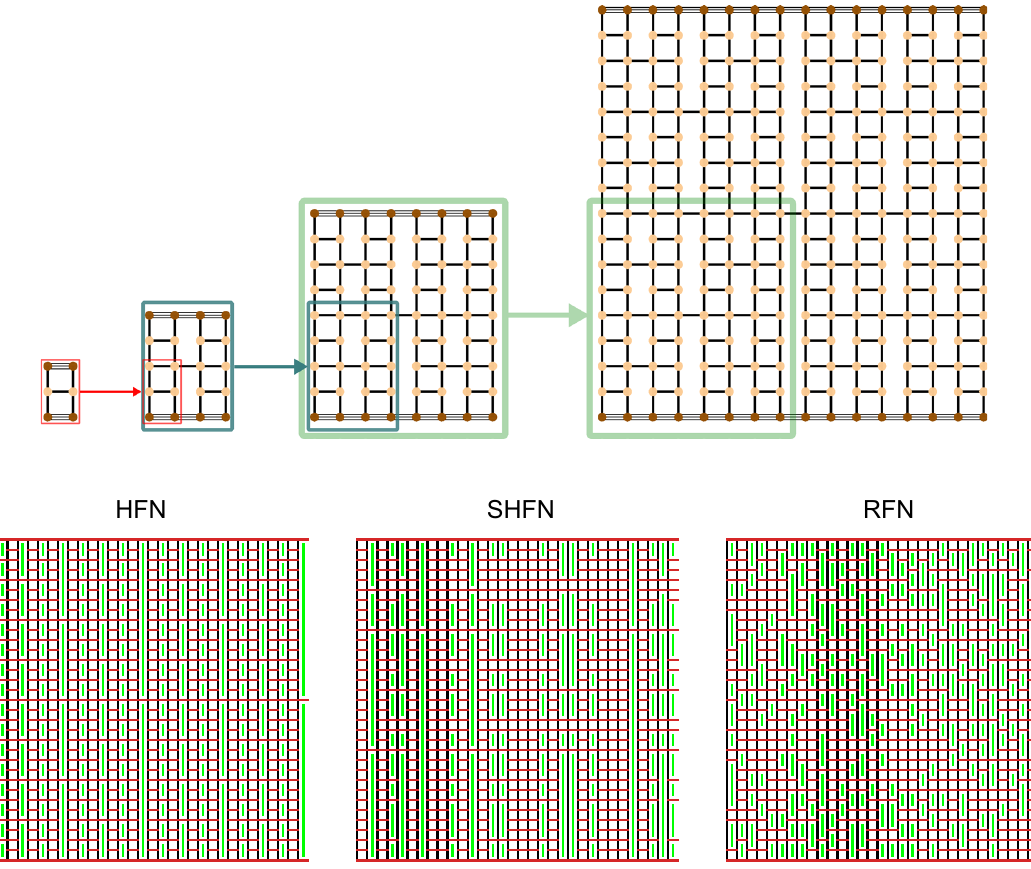
Figure 1. Network models. Top: Bottom-up construction of a HFN. A module of level zero is a load carrying vertical edge. A module of level 1 (generator) consists of 4 level-0 modules plus a load perpendicular cross link which spans the module. Higher level modules are constructed recursively by replacing in a module of level n , each level n − 1 sub-module by a level- n module. The resulting structure defines a module of level n + 1 , as illustrated in the figure up to n = 4 . Circles indicate network nodes. Dark brown circles are boundary nodes, where boundary conditions are applied. Edges are represented as black segments connecting pairs of nodes. Boundary edges (triple segments) are not breakable and are excluded from the statistical GEBC study. Bottom: Examples of HFN, SHFN and RFN of L = 32 . Green lines indicate load parallel gaps 11,13